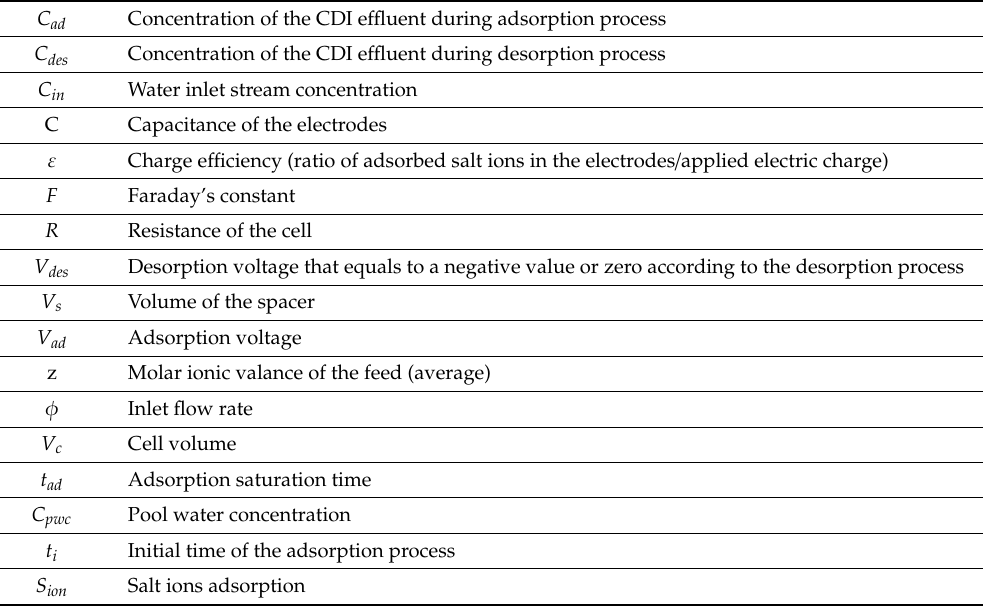
Table 1. As the electrodes are full with change and reverse or zero potential is applied, the already stored charges start moving out of electrodes steadily. While there are no opposite charges to hold the ions in electrodes, to ion starts flowing with the regenerative inlet stream, eventually, electrodes are regenerated. During regeneration, e ffl uent concentration during desorption ( C des ) varies with time and has values greater than inlet concentration ( C in ). The regeneration process is also function of capacitance along with other parameters mentioned in Table 1. Table 1. Parameters used for capacitive deionization (CDI) e ffl uent